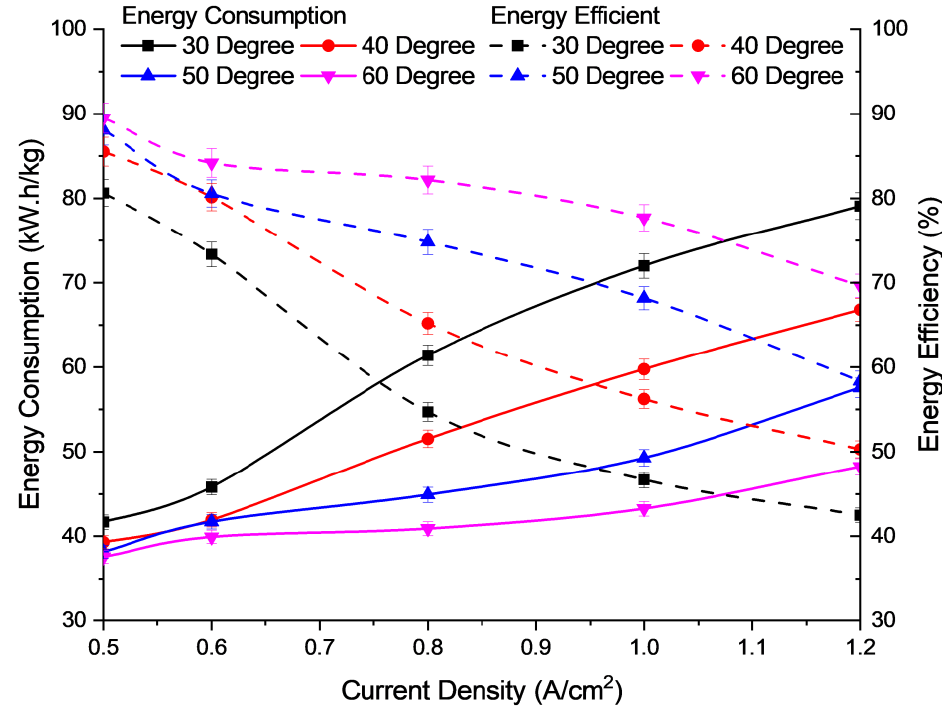
Figure 7. Profile of energy consumption and energy efficiency of electrolysis performance, for different operating temperatures at 6 mL/min flow rate and concentration of electrolyte 2.0 M